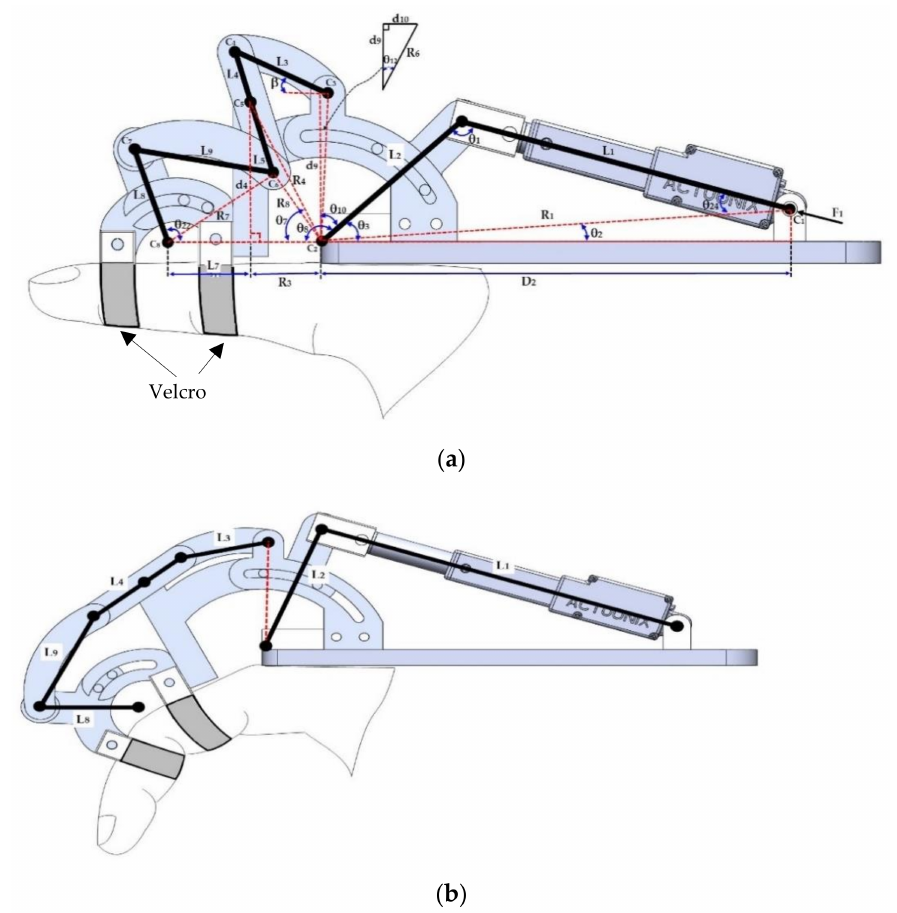
Figure 3. ( a ) Initial position for proposed mechanism from a lateral view and ( b ) analysis of the final position of the